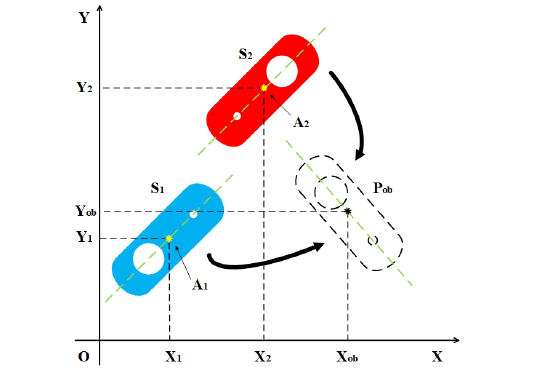
Figure 1. Case where the same rotation angle is obtained with dissimilar poses when using image geometric